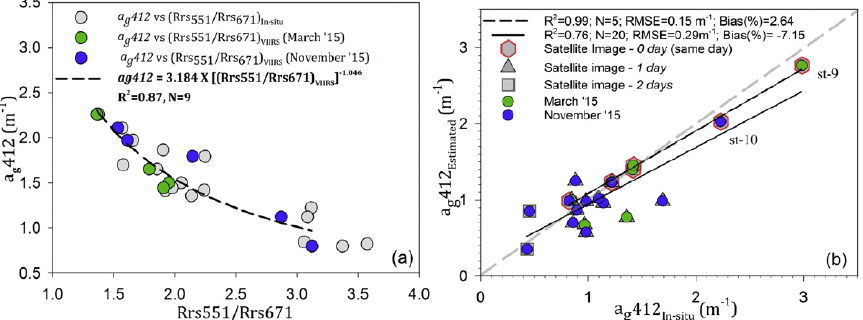
Figure 5. ( a ) A VIIRS based CDOM (ag412) empirical algorithm, ( b ) Validation of VIIRS ag412 against in situ observed ag412 [87]. in situ observed ag412